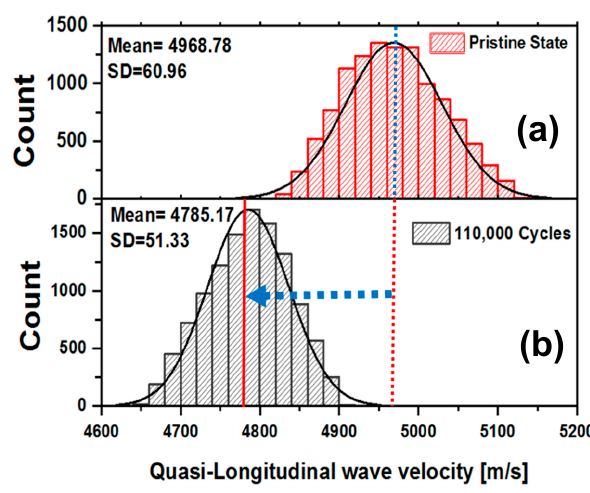
Figure 5. Probability density distribution of wave velocities. ( a ) Pristine state; ( b ) 110,000 cycles.